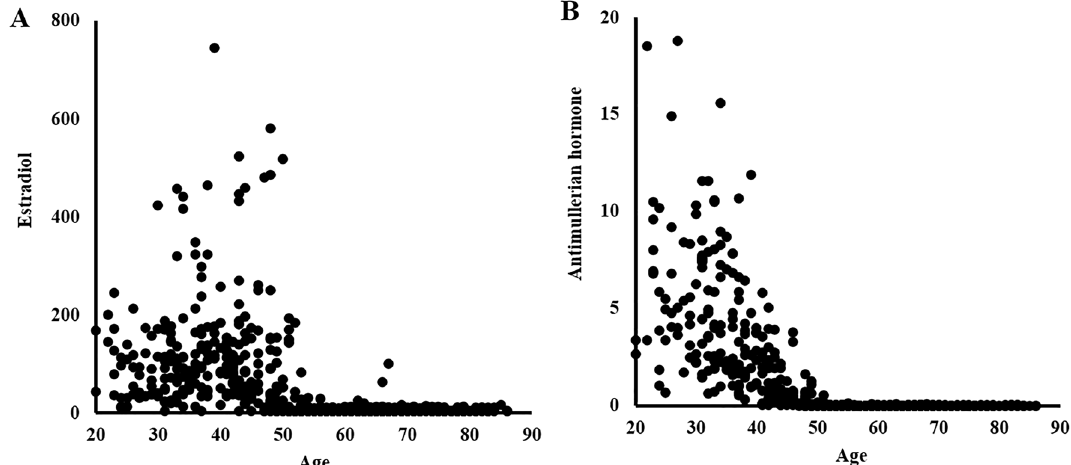
Figure 2. Scatter plot between age and female hormone levels. The distribution of serum estradiol ( A ) and AMH ( B ) per their ages were shown in a scatter